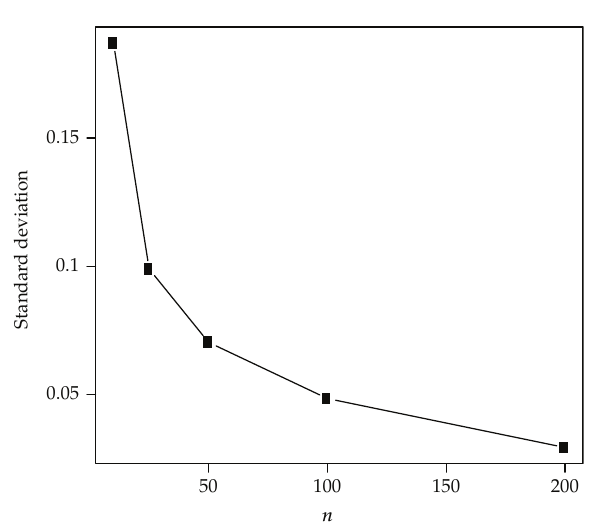
Figure 4: Plot of the standard error of the absolute value of the slope in a bivariate experiment as a function of sample size (cid:2) n (cid:3) .